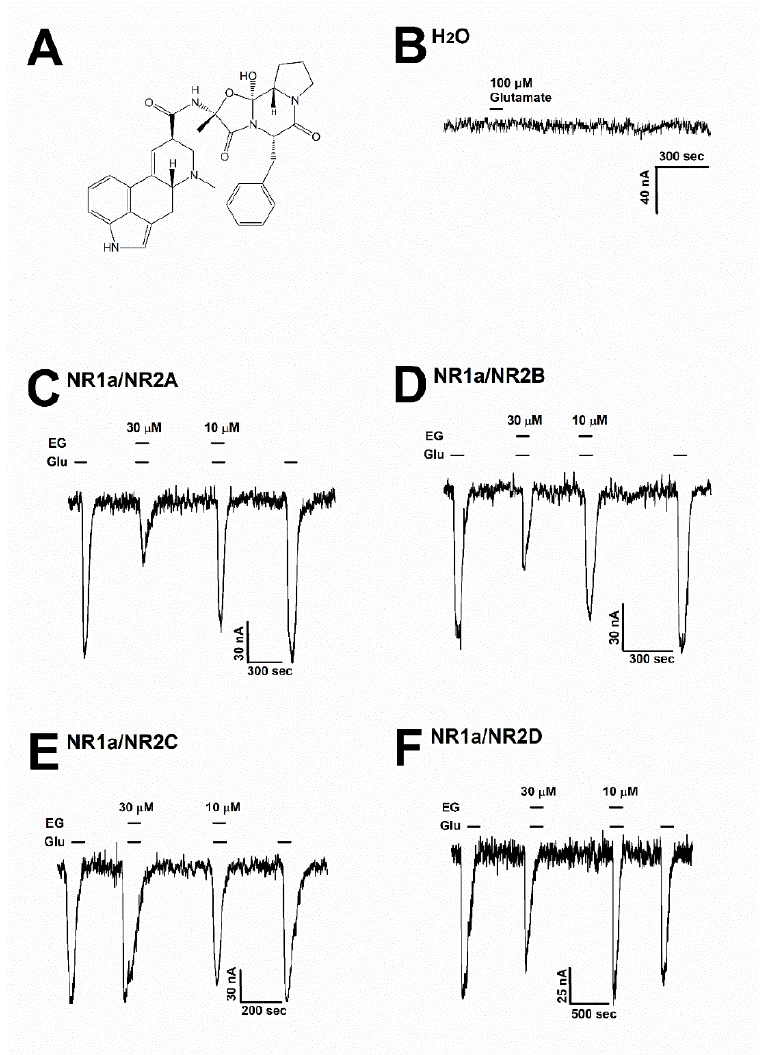
Figure 2. ( A ) The chemical structure of ergotamine. ( B ) The H 2 O-injected oocytes did not cause any change with the treatment of 100 µ M glutamate ( n = 6–8 oocytes from four different frogs). ( C – F ) Glutamate induced inward currents with or without ergotamine (30 µ M and 10 µ M). For each subunit of NMDARs, the responses after treating with either glutamate (100 µ M) alone or together with ergotamine (30 and 10 µ M). Voltage clamp recording was conducted at a holding potential of − 80 mV. The coapplication of ergotamine with glutamate resulted in modulation of the recombinant receptors ( C ) NR1a/NR2A, ( D ) NR1a/NR2B, ( E ) NR1a/NR2C, and ( F ) NR1a/NR2D, which in turn reduced glutamate-evoked inward current in a reversible manner ( n = 6–8 oocytes from four different frogs).